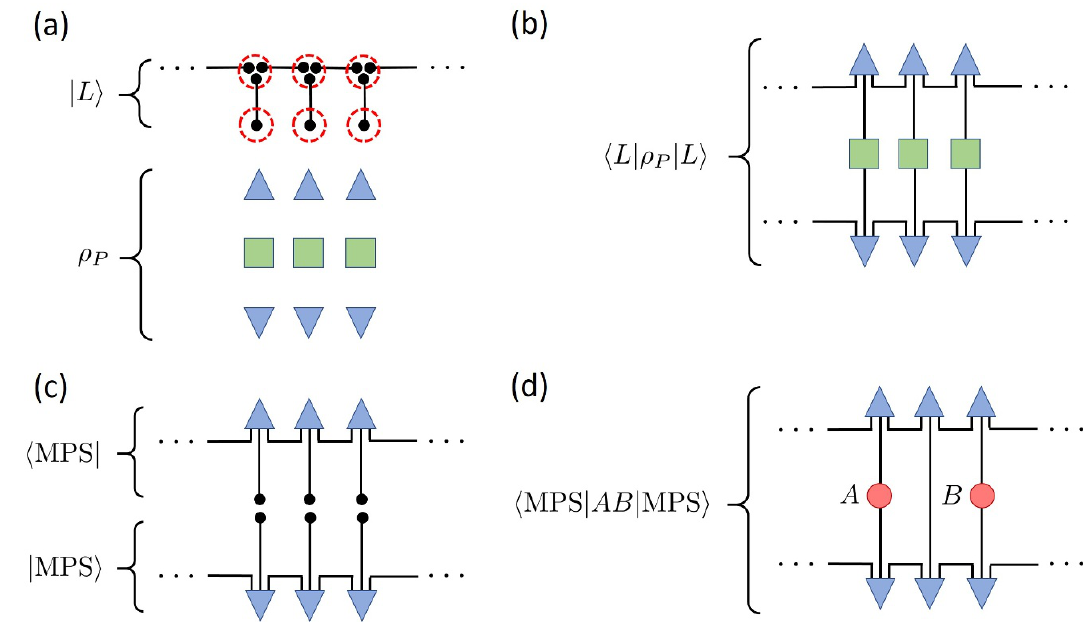
Figure 6 . (a) A diagrammatic representation of j L i and (cid:26) P for a nascent MPS tensor network. The blue triangles represent the 3-qudit pure states h ’ j (each upper triangle) and j ’ i (each lower triangle), and the green boxes are 1-qudit identity operators. Therefore, (cid:26) P = ( j ’ ih ’ j (cid:10) 1 ) (cid:10) N for some N . (b) A diagrammatic representation of h L j (cid:26) P j L i . The green boxes can be omitted since they are identity operators. (c) If we split h L j (cid:26) P j L i by cutting through the vertical links, we obtain two MPS states. (d) A diagram of the two-point function h MPS j AB j MPS i